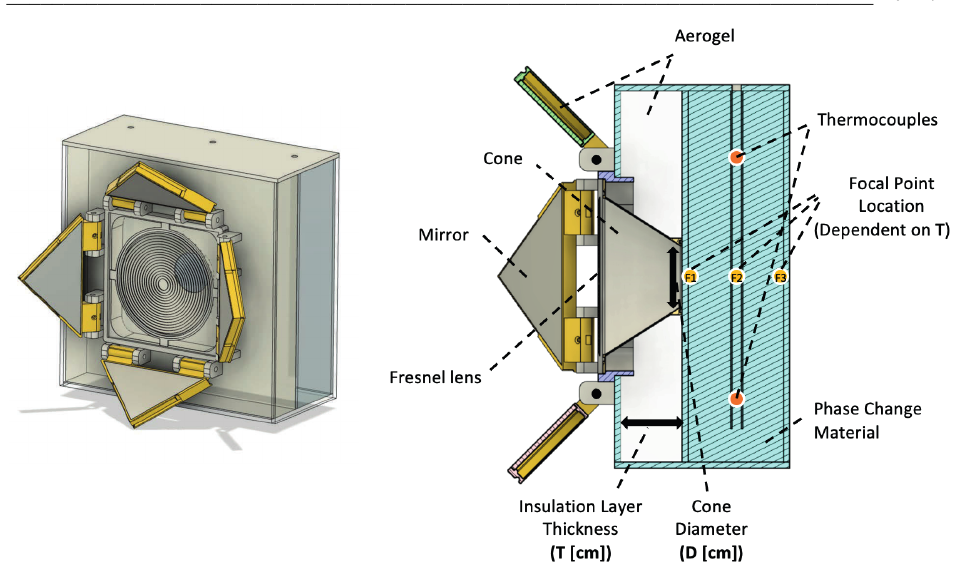
Fig. 3. Design of the small-scale solar facade module and its cross-section